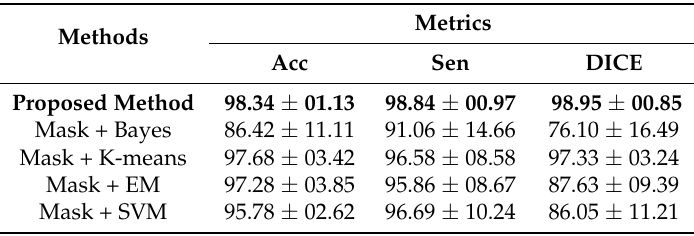
Table 7. Comparisons between methods in the literature that use the Mask R-CNN network based on transfer learning.